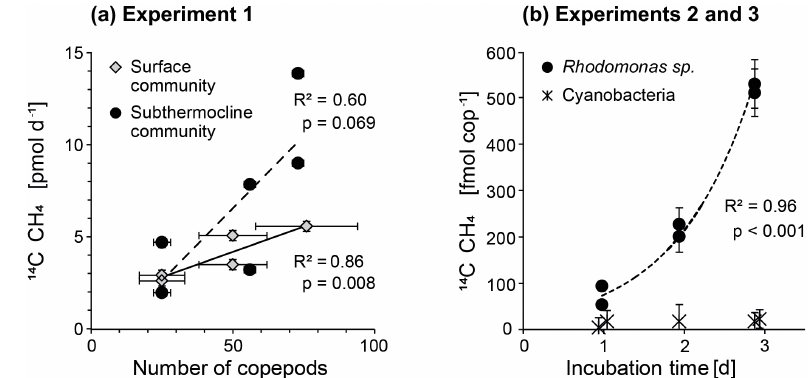
Figure 6. (a) Experiment 1: methane production as a function of the number of copepods in the surface (dominated by Acartia spp.) and subthermocline zooplankton communities (dominated by Temora longicornis ). (b) Experiments 2 and 3: copepod-specific methane produc- tion over time when using the cryptophyte alga Rhodomonas sp. (experiment 2) or the cyanobacterium Nodularia spumigena (experiment 3) as food sources.